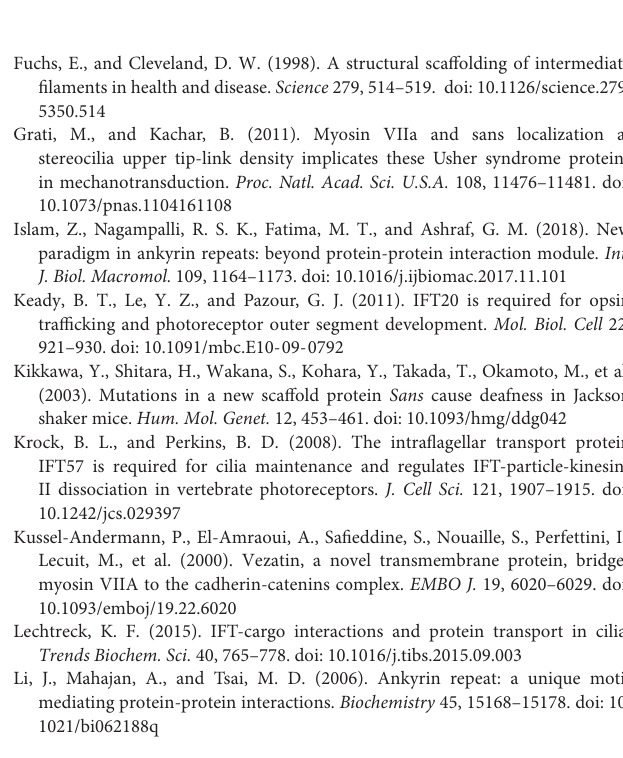
FIGURE S1 | Effects of pathogenic SANS mutations on SANS-IFT interaction. (A) Localization pathogenic mutations p.Leu48Pro and p.Met104Val in the SANS molecule into human SANS. (B) Western blot analysis of GFP-Trap of FLAG-SANS, wild type, p.Leu48Pro and p.Met104Val, respectively, by GFP-tagged IFT52 and IFT57, immobilized on GFP-Trap beads. (C) Quantification of the recovery of FLAG-tagged SANS polypeptides by IFT-GFP-Traps indicating that the recovery of mutated SANS protein is drastically